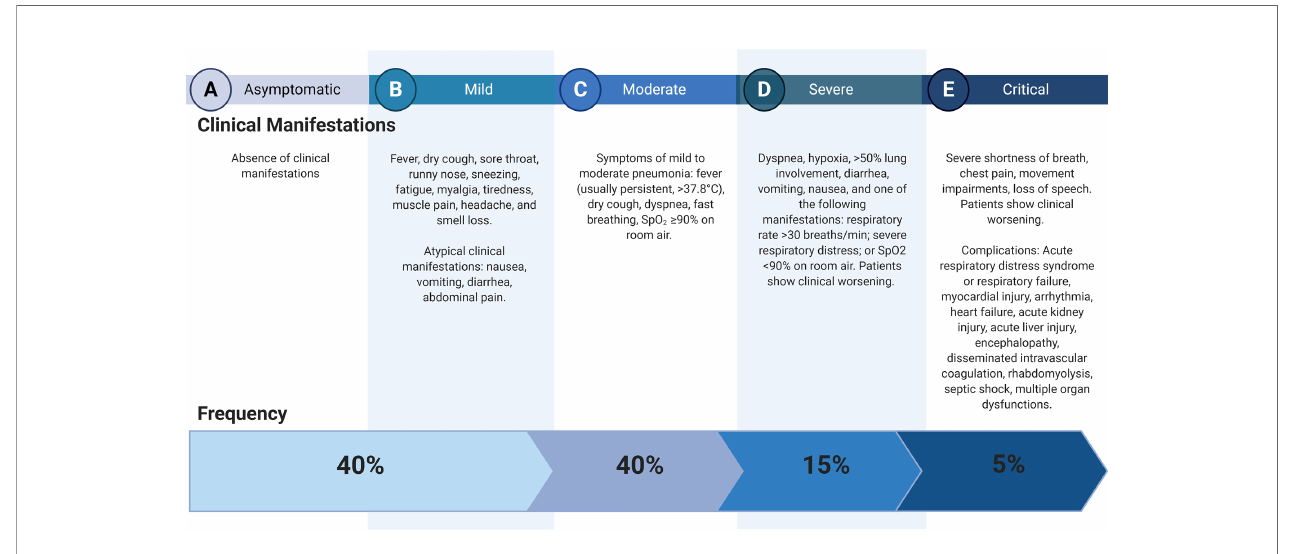
FIGURE 1 | Clinical courses of COVID-19. Data (2) and Clinical management of COVID-19, interim guidance (3). Created with